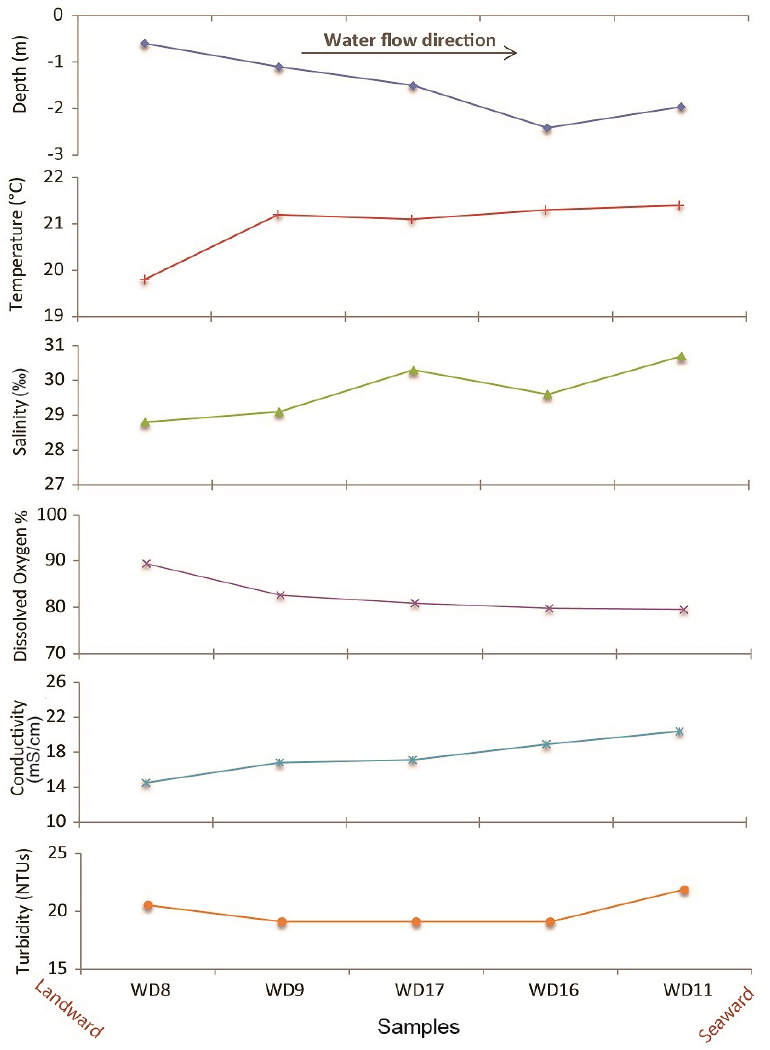
Figure 14. Water sample analyses show spatial changes in; conductivity, salinity, dissolved oxygen and turbidity, (sample locations have presented on Figure 1).